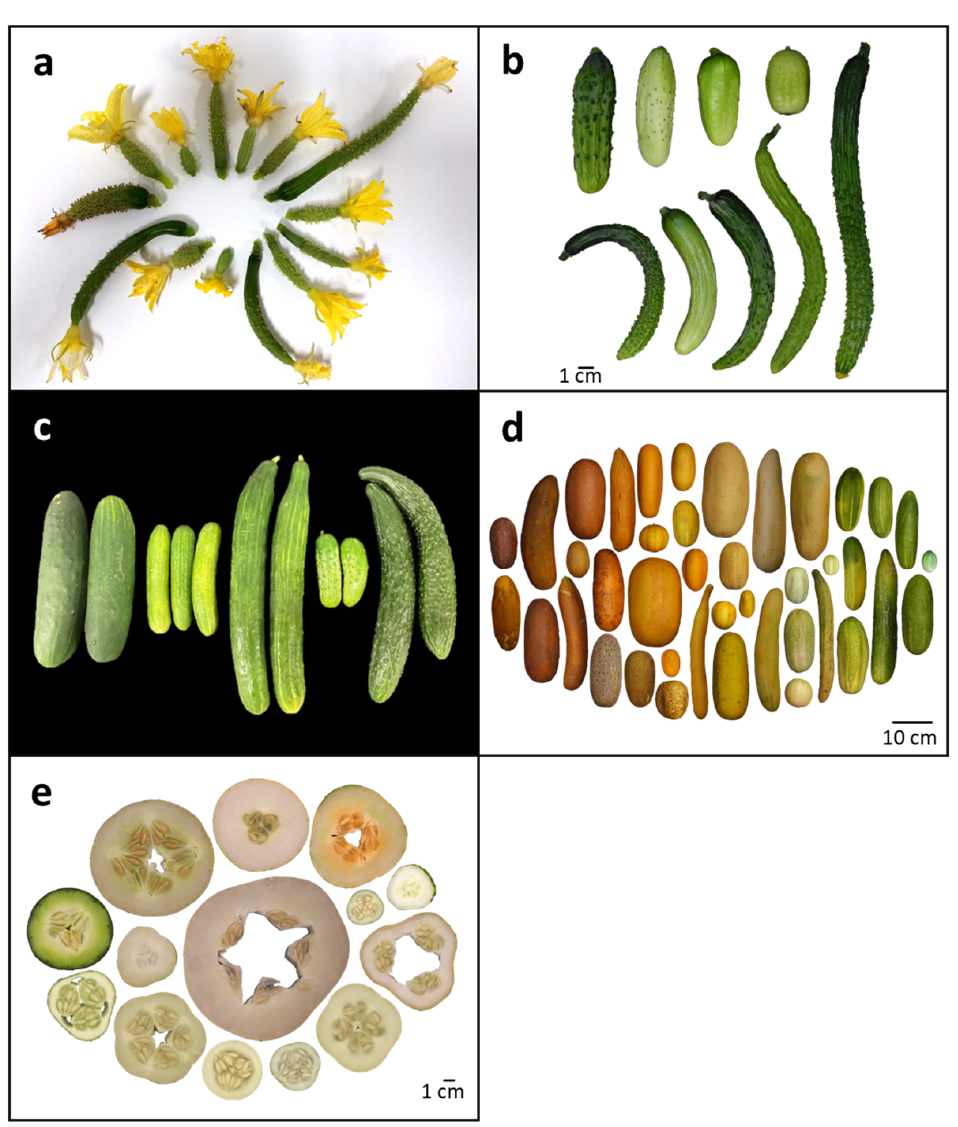
Figure 1. Examples of diversity in cucumber ovary and fruit morphology at different stages of development as observed in the CucCAP cucumber core collection [1]. ( a ) Cucumber ovaries at anthesis or one day post-anthesis exhibit differences in size, shape, presence/absence/number of spines, spine color, warts, and ribs. ( b ) Variation in cucumber fruit development during early exponential growth 5–8 days post pollination (dpp). ( c ) Examples of cucumber market types. Left to right: Western fresh market (slicing); Beit Alpha/Mediterranean; parthenocarpic greenhouse; Western pickling; Chinese Long. ( d ) Mature cucumber fruit vary in shape, size, color, surface texture, and netting. ( e ) Variation in internal properties at maturity (flesh thickness, seed cavity size, color, and